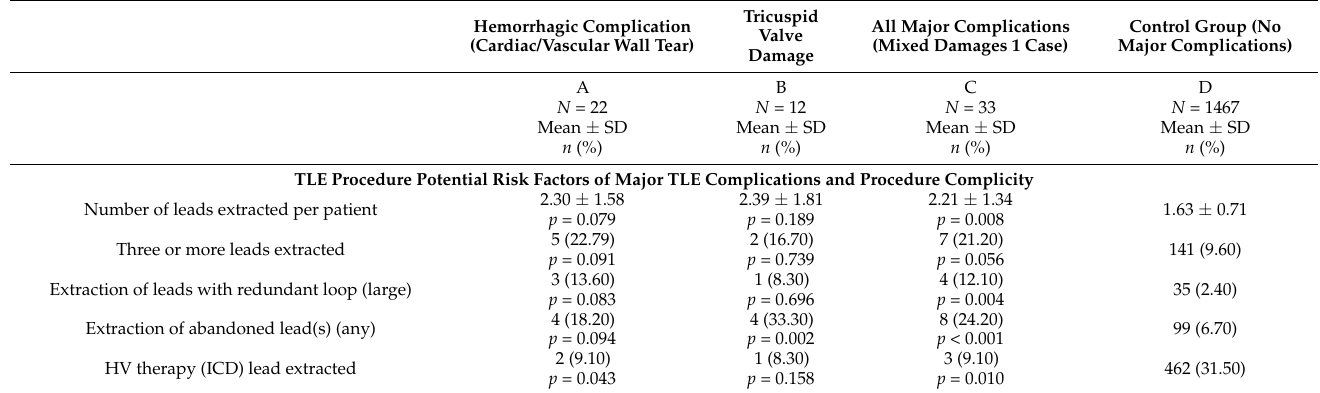
Table 2. Patient/system/history of